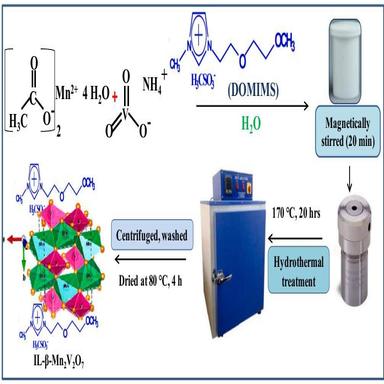
Synthesis of IL-β-Mn2V2O7 nanorods.